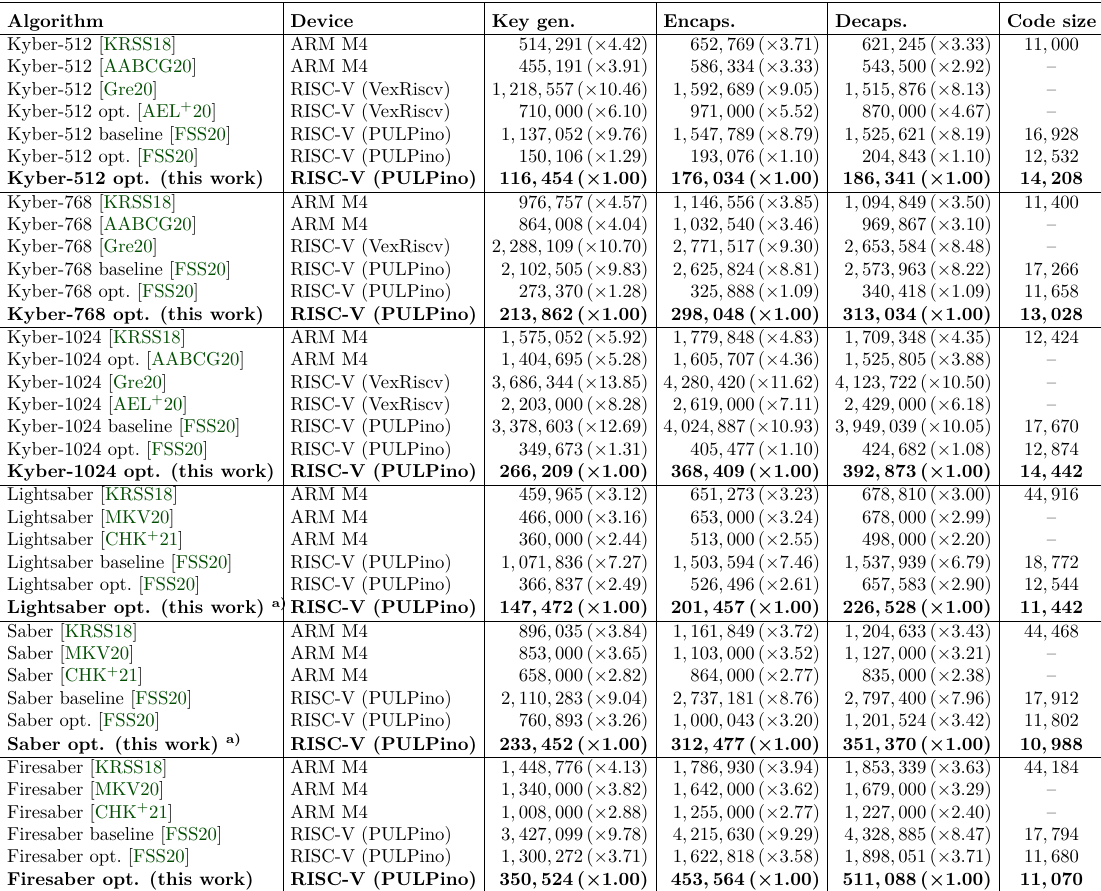
Table 7: Cycle count and code size in bytes non-masked and optimized ( -O3 , GCC PULPino RISC-V compiler 7.1.1